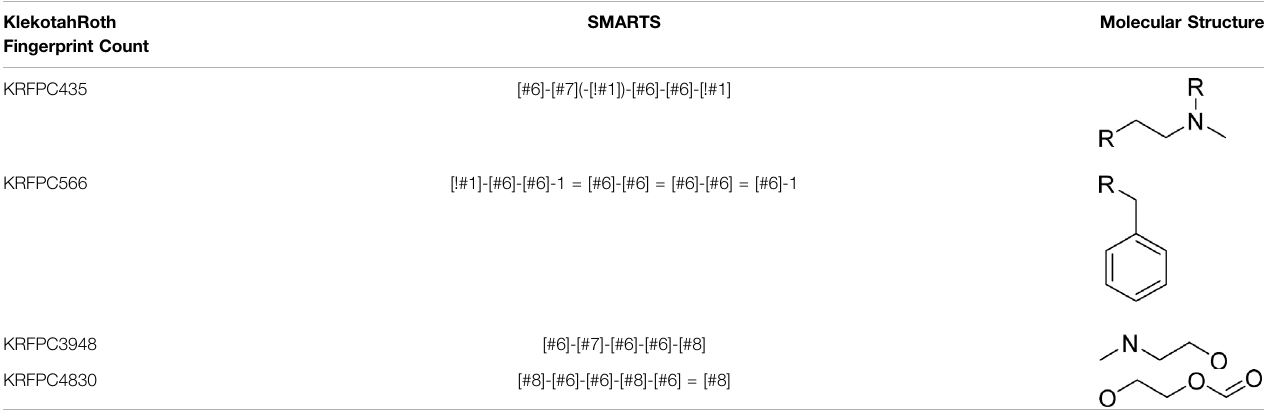
TABLE 6 | SMARTS patterns associated with set of descriptors of the fi nal LDA model. R represents any atom other than